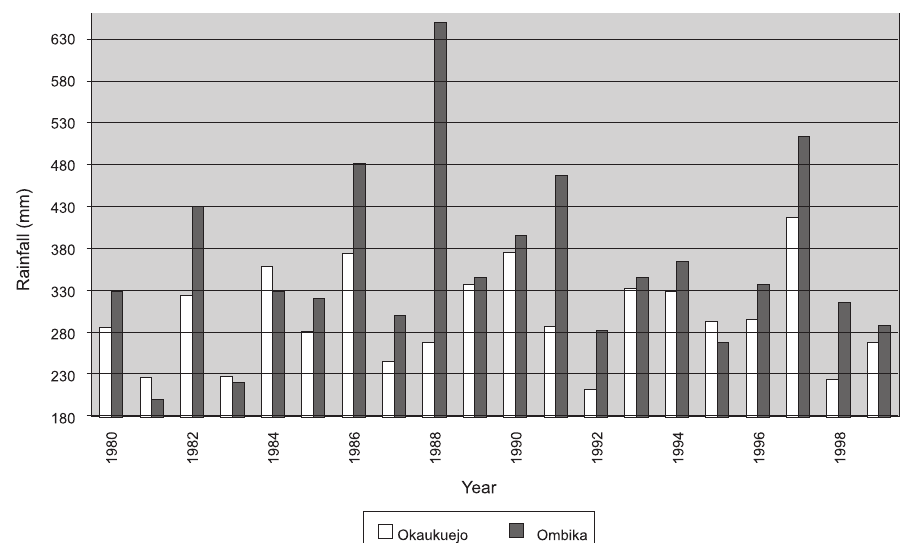
Fig. 1. Annual rainfall received at Okaukuejo and Ombika between 1980 and